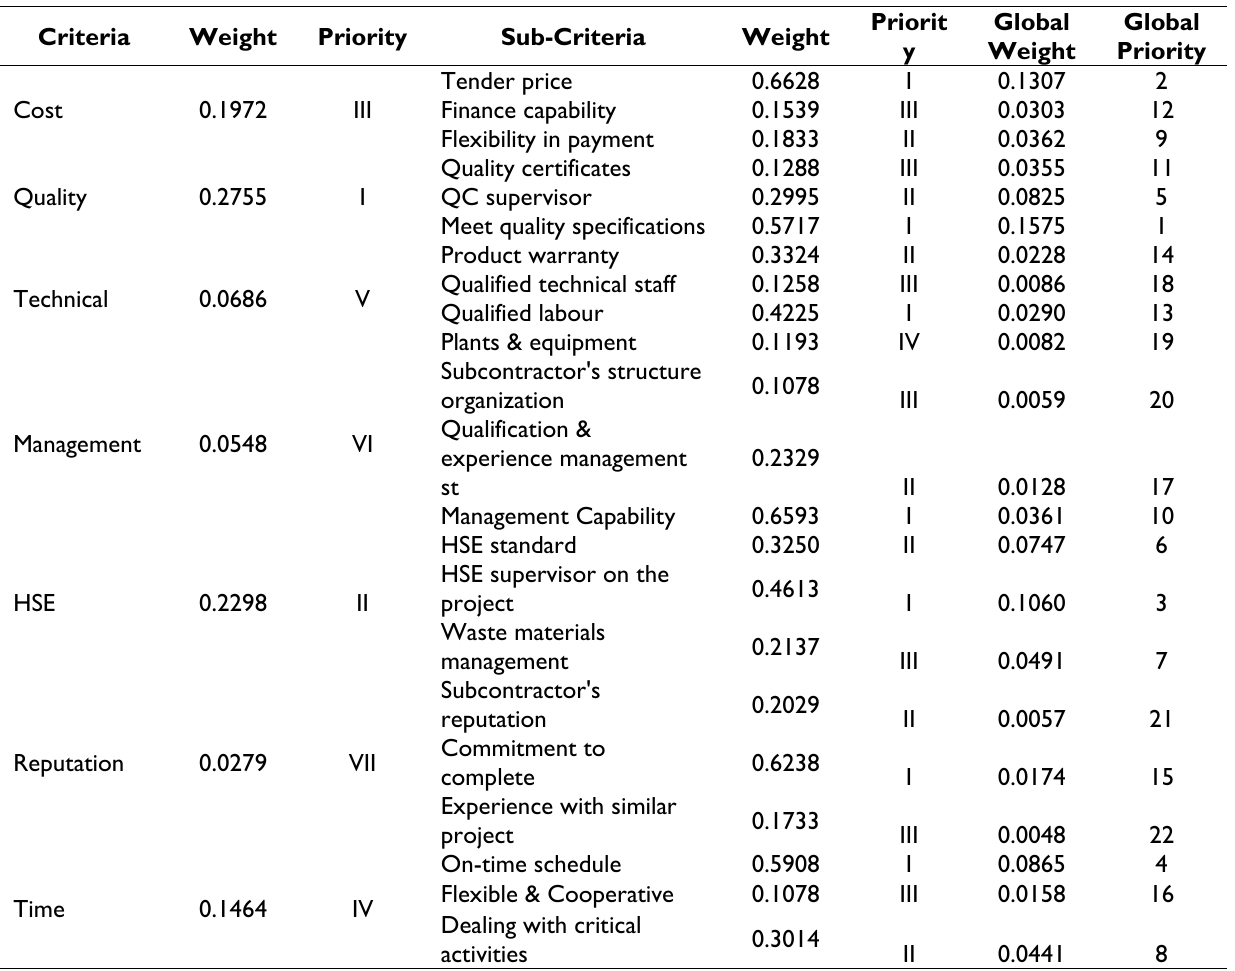
Table 2. Global priority weight with the AHP